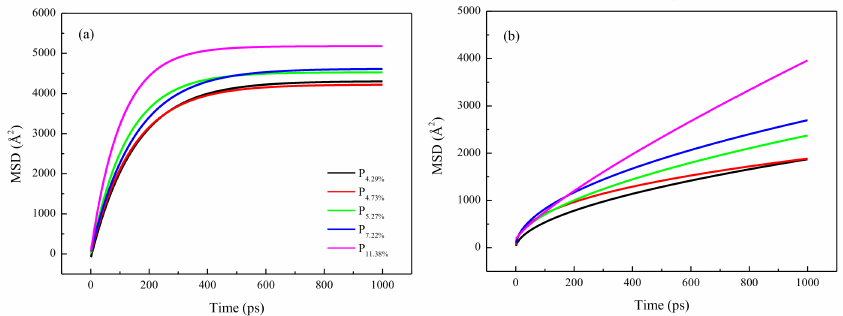
Figure 4. The mean squared displacement of H 2 O ( a ) and N 2 ( b ). Figure 4b delineates the MSD of N 2 along the z -axis in the nanopores of SiO 2